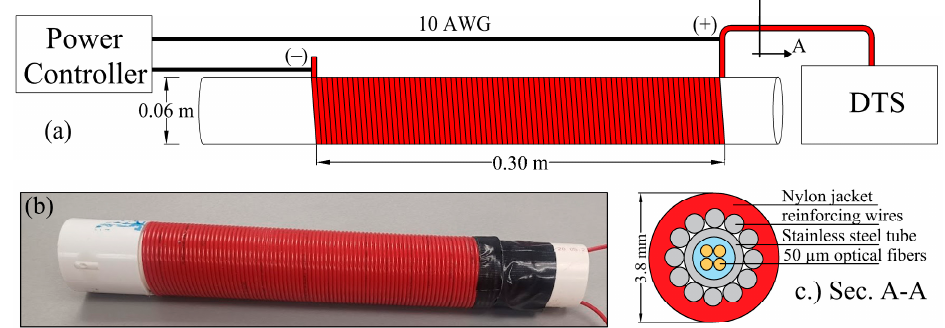
Figure 1. The FO-DTS scour-monitoring device: ( a ) schematic diagram of the constructed FO-DTS device, ( b ) photo of the actual device, and ( c ) cross-section of the used FO cable. A Silixa XT ® (Silixa Ltd., UK) DTS system with sampling and temporal resolutions of 0.25 m and 5 s was used to monitor the temperature over the whole length of the FO cable.